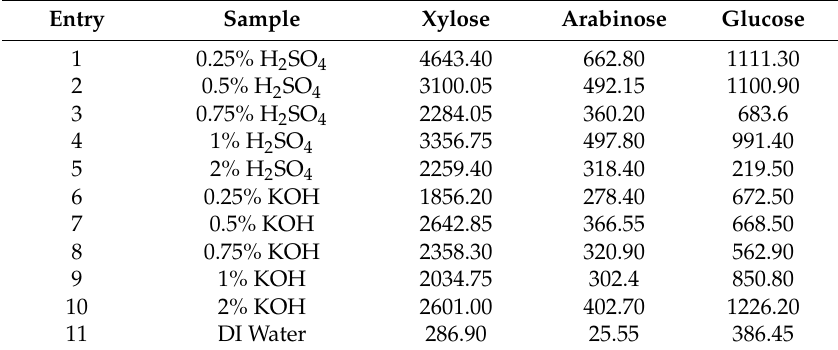
Table 3. Effect of the pretreatment conditions on the catalytic performance of bamboo-derived magnetic solid acid (mg/L).